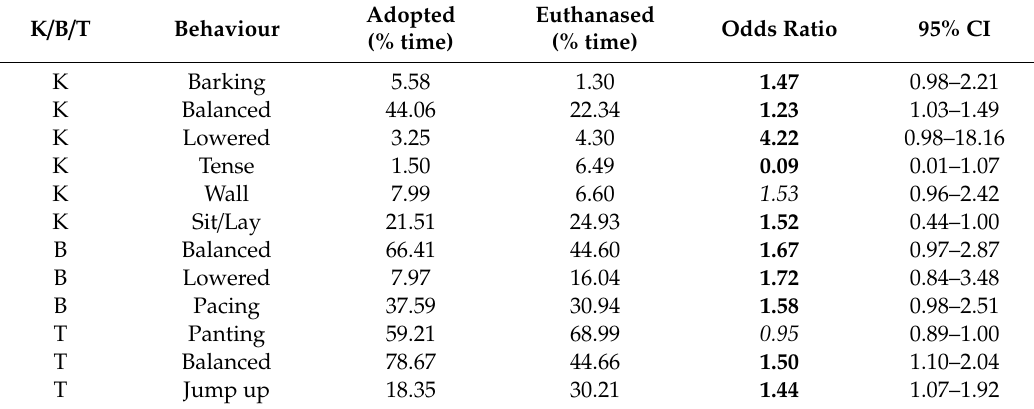
Table 11. Time spent in behaviours in the kennel, the formal assessment and time alone test of dogs ( n = 38) that were adopted or euthanased, with Odds Ratio and Confidence Interval (CI) tested by binary logistic